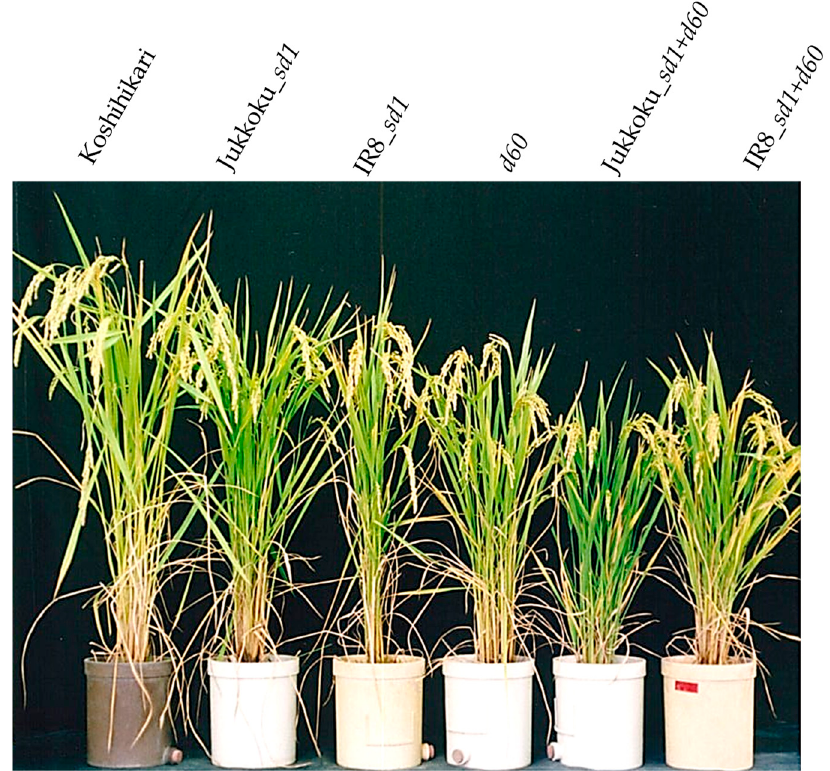
Figure 3. Plant phenotype of semidwarf and double dwarf gene lines. Leaves of the semidwarf and double dwarf lines were straighter (pointing upwards) than in Koshihikari, indicating improved light-reception attitude by the integration of semidwarf gene (or genes).